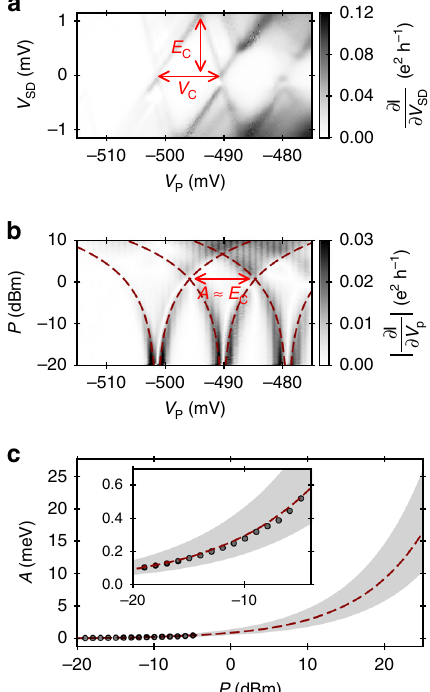
Fig. 6 Estimation of the SAW amplitude. a Exemplary Coulomb-diamond measurement allowing the extraction of the voltage-to-energy conversion = V factor η ¼ E . b Broadening of the corresponding Coulomb-blockade C C peaks with increasing transducer power, P . c Amplitude of SAW-introduced potential modulation. The dashed line shows a fi t of Eq. (5) to the experimentally obtained data. The con fi dence region (grey area) is roughly estimated from variations of measurements on four QDs on a similar sample. The plot shows an extrapolation of this region to the typically employed transducer power of 25 dBm. The inset shows a zoom into the data